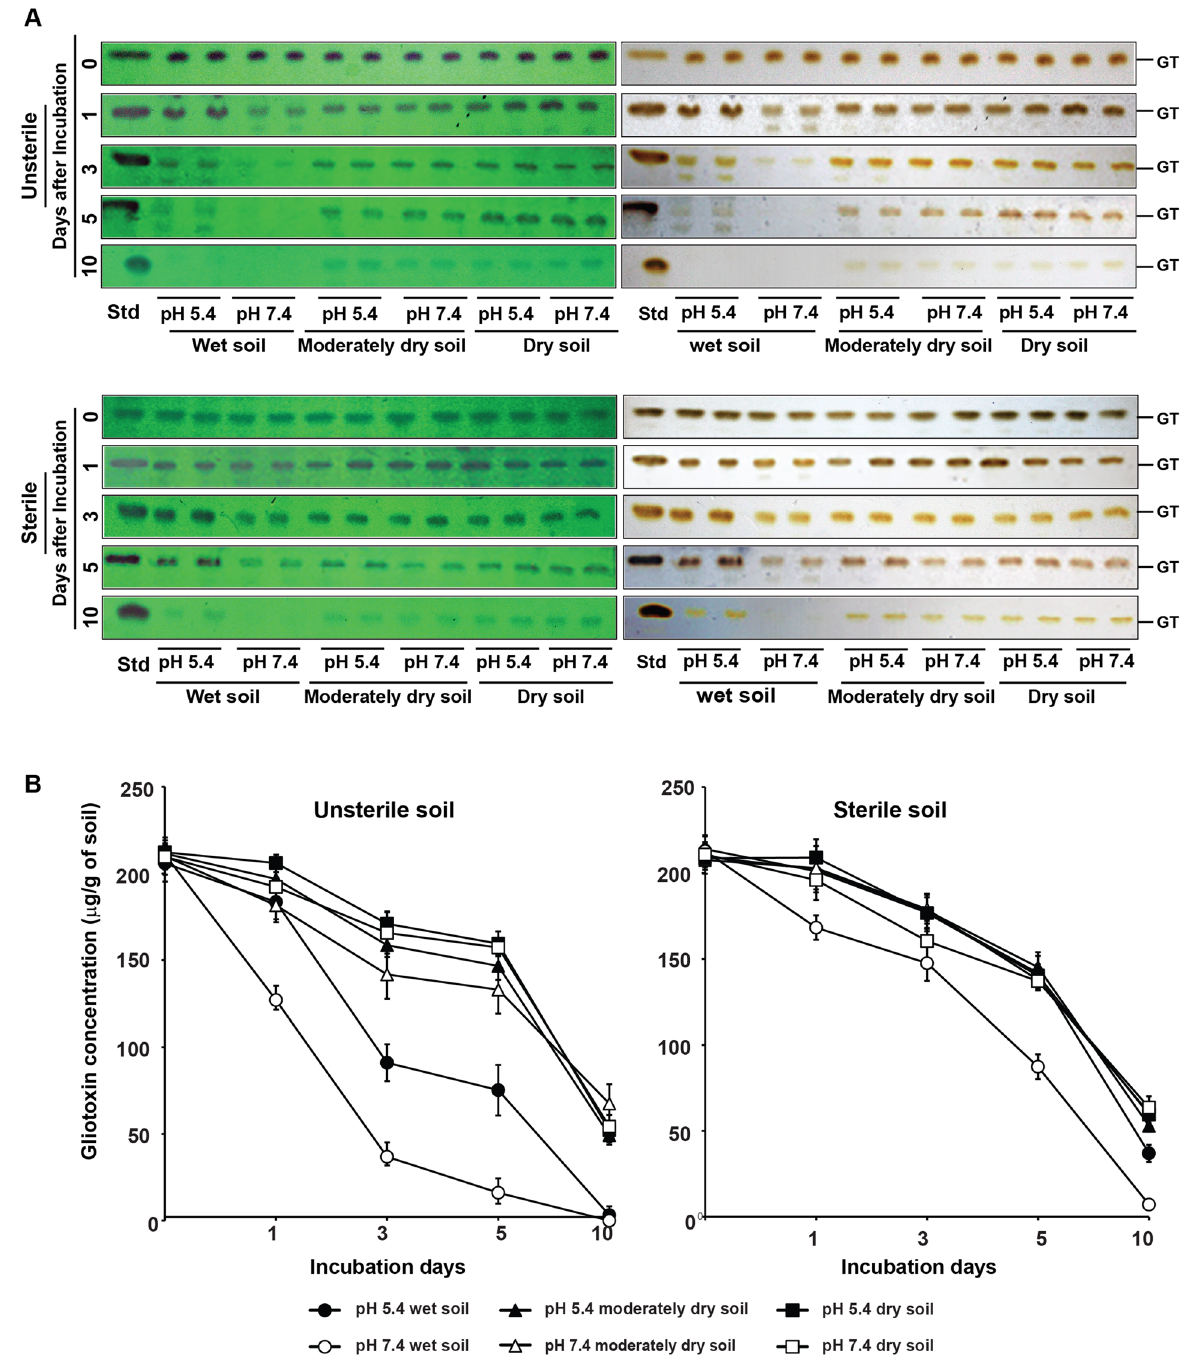
Figure 7. Stability of gliotoxin in agricultural soil. ( A ) Gliotoxin was added to sterilized and unsterilized acidic sandy loam soil (pH 5.4) and alkaline sand loam soil (pH 7.4) @ 250 µg/g of soil and incubated at 30 °C for 10 days. Soil samples were taken at 0, 1, 3, 5 and 10 days after incubation and levels of gliotoxin was analysed as explained in Fig. 2A. GT gliotoxin, Std standard gliotoxin. ( B ) Stability of gliotoxin was semi-quantitatively measured by densitometry analysis. Blue band intensity and density was measured using Gel Quant NET software and concentration was calculated using standard curve as explained in